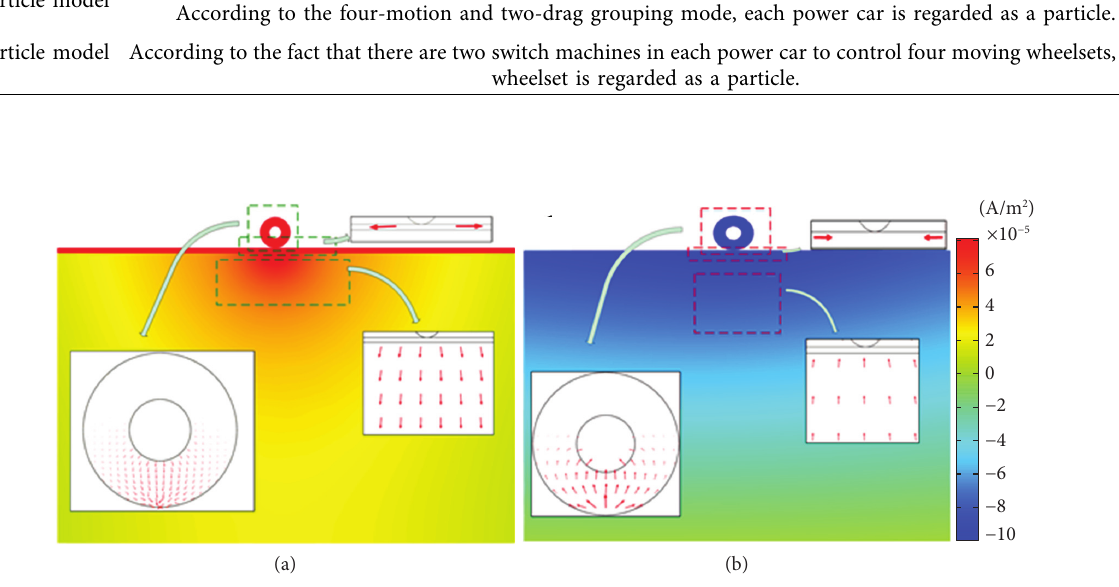
Figure 4: Traction current reflux path. (a) Positive traction current. (b) Negative traction current.